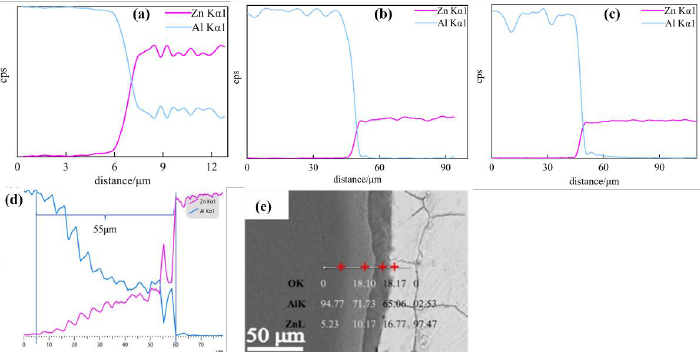
Figure 4. SEM morphology images of interface at different annealing temperatures for 1.5 h. ( a ) 200 °C; ( b ) 240 °C; ( c ) 280 °C; ( d ) 320 °C.